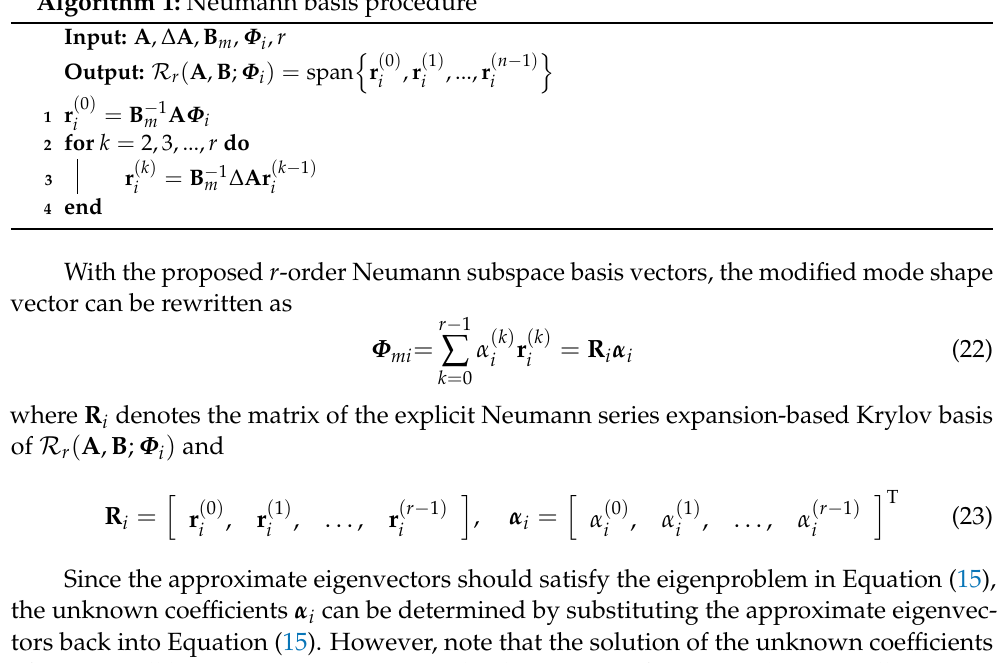
Algorithm 1: Neumann basis